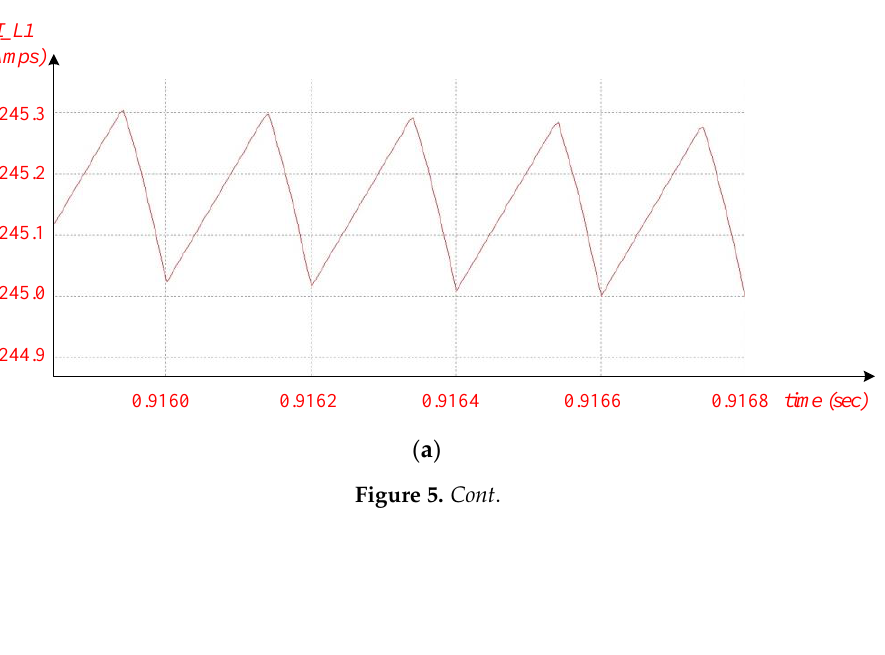
( b ) Figure 5. Current waveforms of the inductors: ( a ) L1, and ( b ) L2. Currents through both the inductors, L1 and L2, do not completely cease during a switching cycle and hence prevent the converter from entering discontinuous-conduction mode (DCM). 5.2. Output DC Voltage Simulation response of the voltage gain, shown in Figure 6, demonstrates that the converter remained in the transient state for less than 0.2 s and enters quickly into the steady-state phase. 80 60 40 20 0 Vo (Volts) 0 0.5 1 1.5 time (sec) Transient duration Steady-state duration Figure 6. Output voltage simulation waveform for D = 0.75.